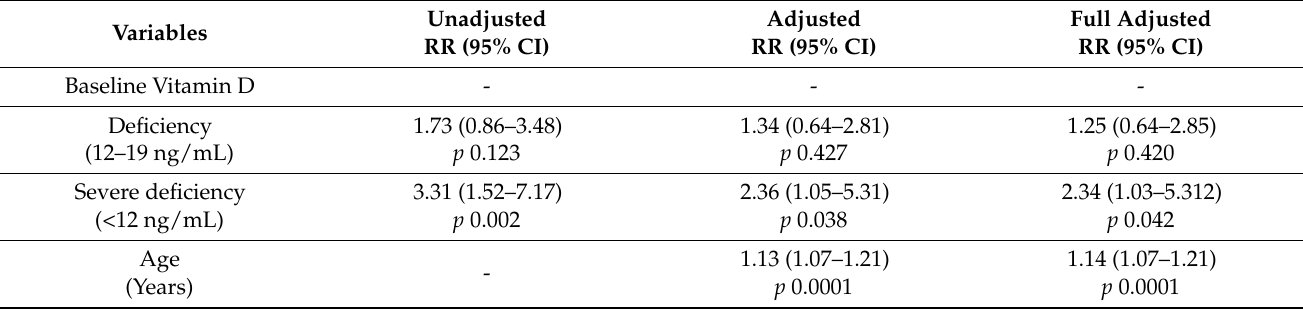
Table 3. Penalized logistic models for Mild cognitive Impairment risk According to baseline vitamin D